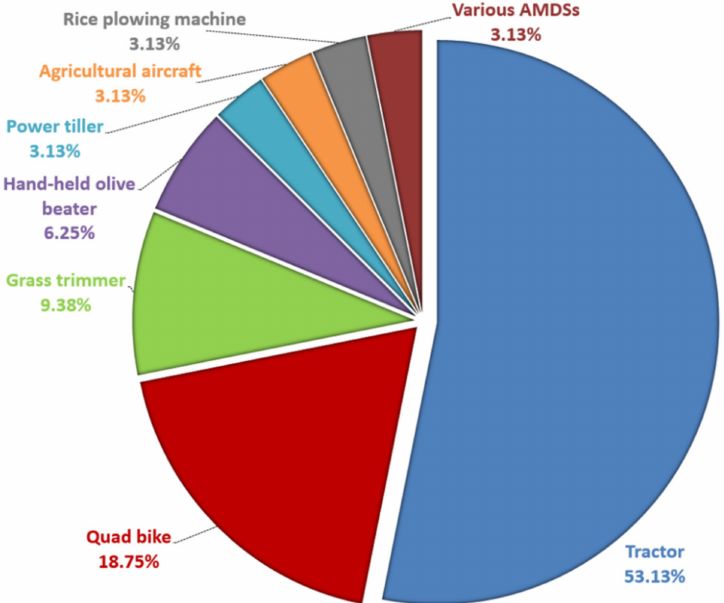
Figure 7. Distribution of the di ff erent kinds of studied agricultural machines causing musculoskeletal disorders; abbreviation AMDSs corresponds to agricultural machines with driving